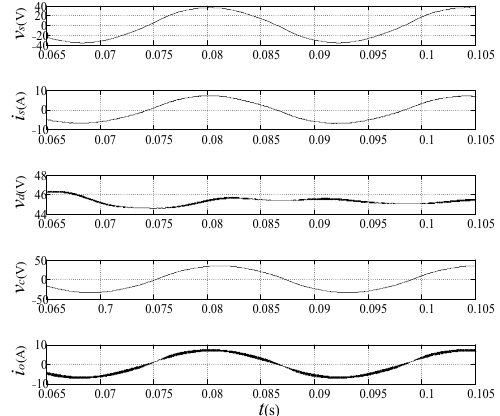
Figure 7. Waveforms under traditional modulation strategy.